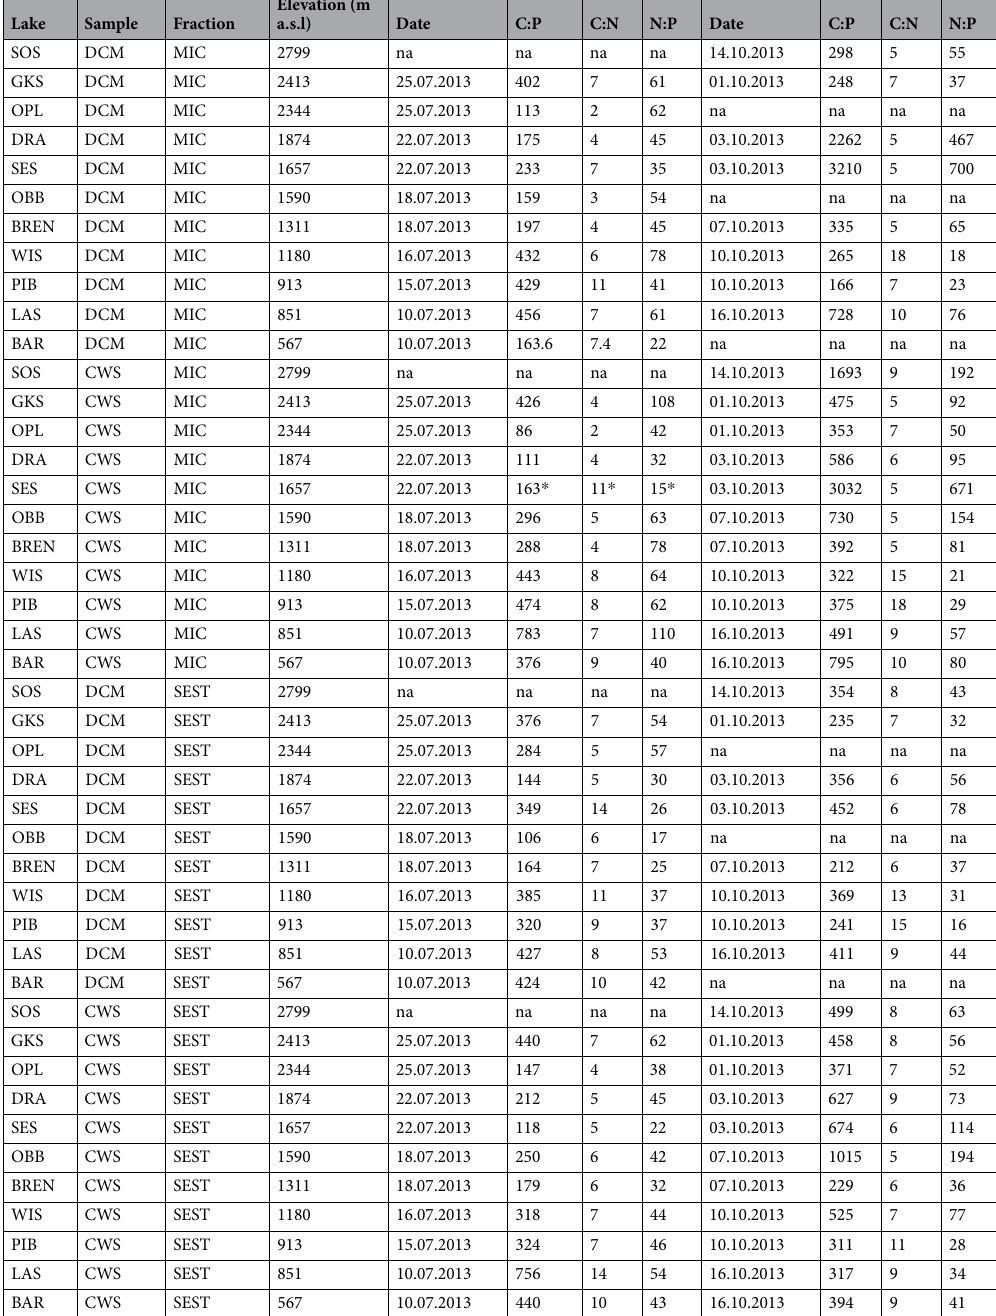
Table 2. Stoichiometry of the microbial (MIC) and seston (SEST) fractions in composite water samples (CWS) and in samples from the deep chlorophyll-a maximum (DCM). C:P, C:N, N:P are mean molar ratios. * indicates only one replicate. BAR: Baggersee Rossau, LAS: Lansersee, PIB: Piburgersee, WIS: Wildsee bei Seefeld, BREN: Brennersee, OBB: Obernbergersee, SES: Sebensee, DRA: Drachensee, OPL: Oberer Plenderlesee, GKS: Gossenköllesee, SOS: Schwarzsee ob Sölden. na: data not Stoichiometry of the microbial and seston fractions. The C:P ratios of the microbial fraction were in almost all cases higher than the Redfield ratio (Table 2). In most lakes, the microbial fraction was P-depleted relative to C in July (mean C:P: ~345) with the exception of OPL and Drachensee (DRA). In July, the microbial fraction of these two lakes exhibited a C:P very close to 106, whereas in October the microbial fraction of all lakes was poor in P compared to C. The microbial fraction of the four subalpine lakes situated at low elevation (i.e., 567–1180 m a.s.l.) and that of Gossenköllesee (GKS) and Sebensee (SES) was slightly N-depleted compared to Redfield (6.6). In July, the C:P ratios of the seston fraction showed the same trend as that of the microbial fraction. The seston of almost all lakes was P-depleted relative to C, especially in the subalpine lakes and in the alpine lakes